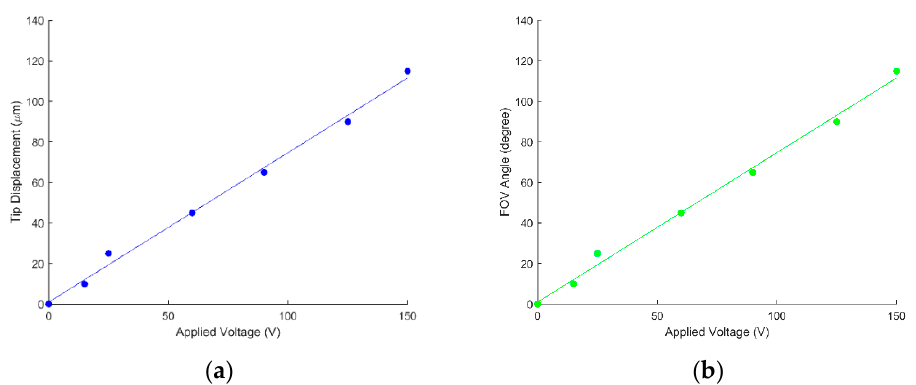
Figure 23. ( a ) Waveguide tip displacement and ( b ) corresponding scanning angle vs. applied voltage at 1 Hz driving frequency.